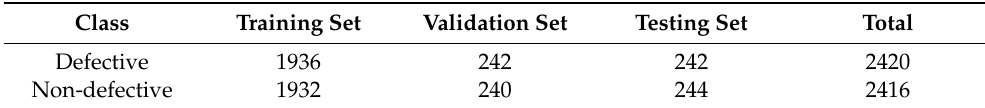
Table 2. The dataset division for binary classification.